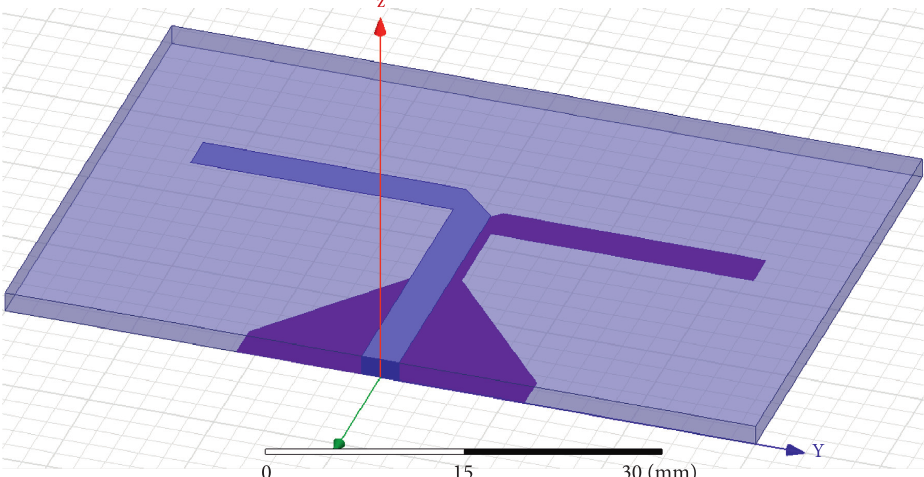
Figure 6: HFSS model of the